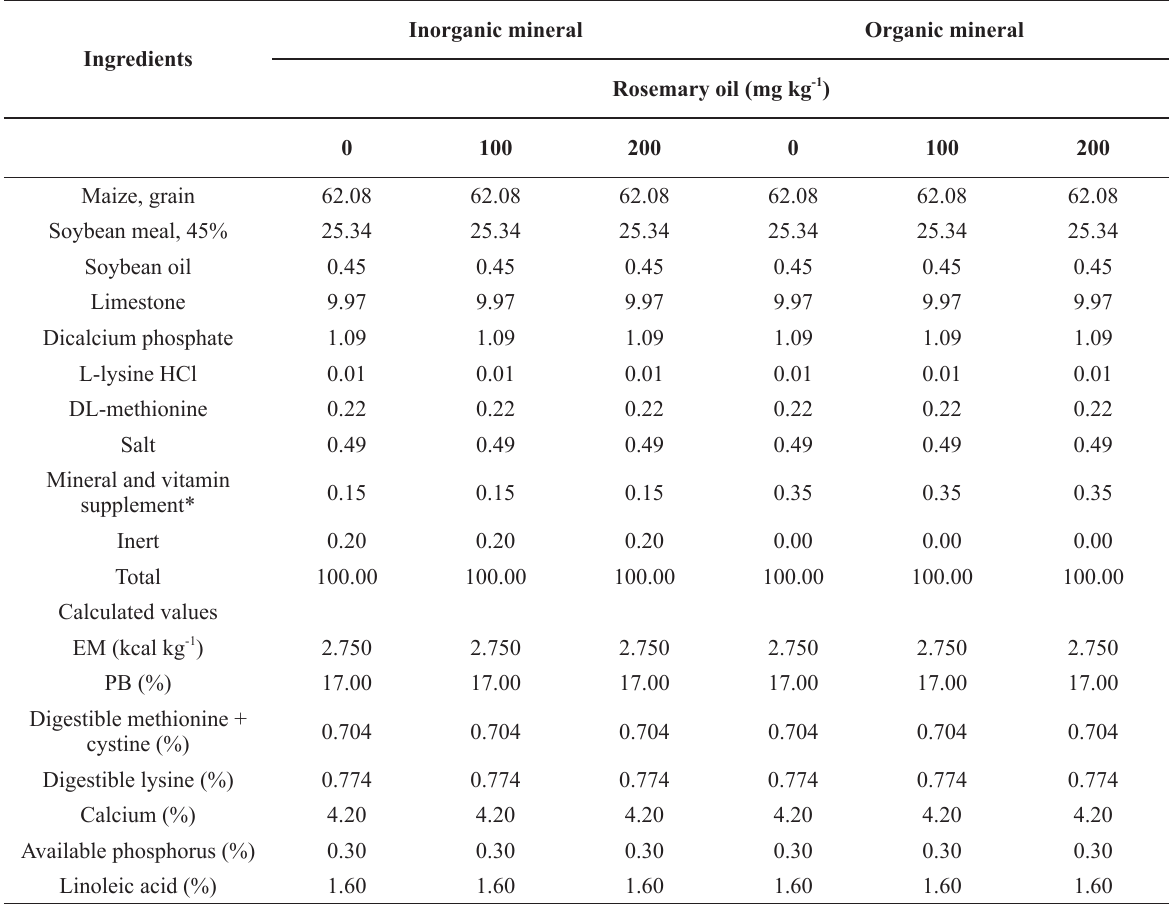
Percent and calculated compositions of experimental